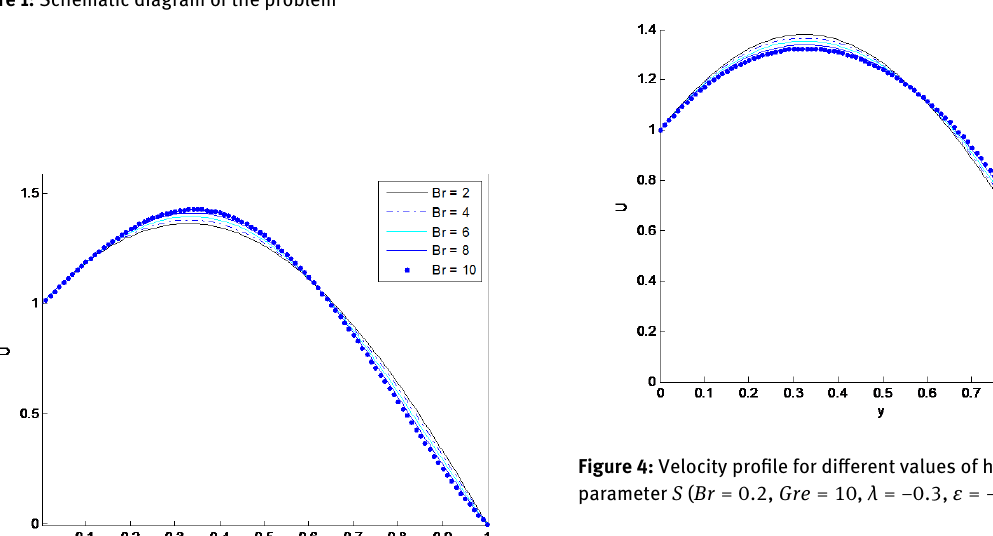
Figure 1: Schematic diagram of the problem